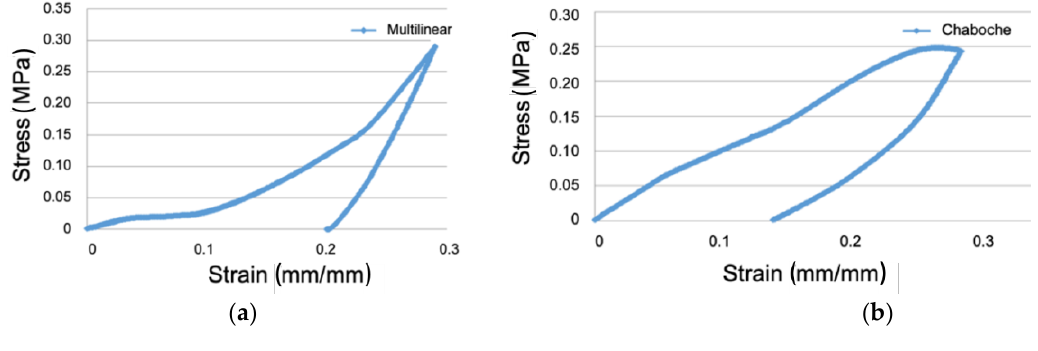
Figure 14. Discretization by advanced hardening models: ( a ) multilinear isotropic; ( b ) Chaboche